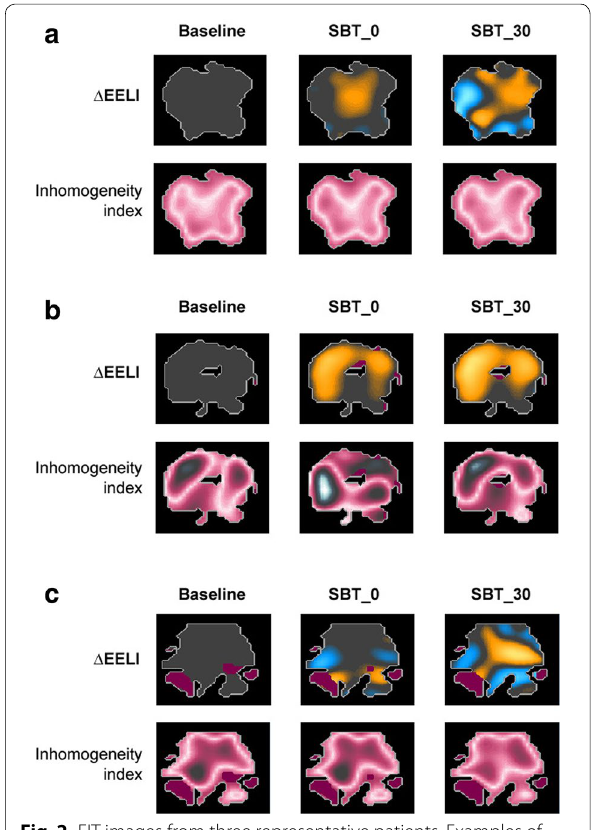
Fig. 2 EIT images from three representative patients. Examples of EIT images from three representative patients, two succeeding ( a , c ) and one failing ( b ) the SBT. ∆EELI and the inhomogeneity index are shown at baseline, SBT_0 and SBT_30. For ∆EELI, the yellow and blue colour codes indicate EELI loss and increase, respectively. A pink scale code depicts inhomogeneity of gas distribution within the lungs. a Characterized by a relatively small ∆EELI, as referenced to baseline, at both SBT_0 ( 181 ml) and SBT_30 ( 178 ml). The inhomogeneity − − index is stable, ranging between 35 and 40 in all three trials. In b , conversely, ∆EELI is much greater ( 752 ml at SBT_0 and 824 ml at − − SBT_30), indicating a remarkable loss of end-expiratory lung volume at both time points. The pink colour is quite scattered, indicating elevated values of inhomogeneity (54, 72 and 69, at baseline, SBT_0 and SBT_30, respectively). In c , ∆EELI does not significantly change ( 110 ml at SBT_0 and 117 at SBT_30), while the inhomogeneity − − index is increased (68, 70 and 71 at baseline, SBT_0 and SBT_30, respectively). Notably, in contrast to the two previous examples, this patient was affected by chronic obstructive pulmonary